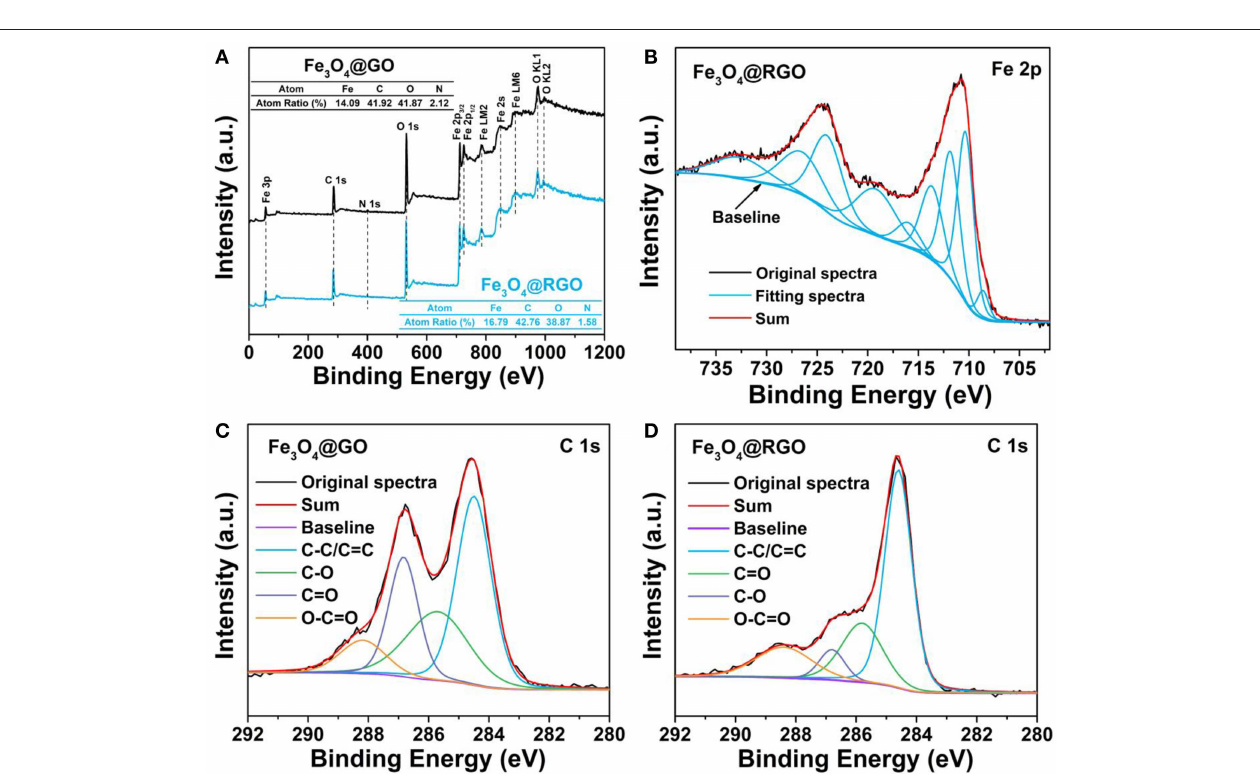
cm − 1 , respectively (Liu et al., 2017), as shown in Figure 4B